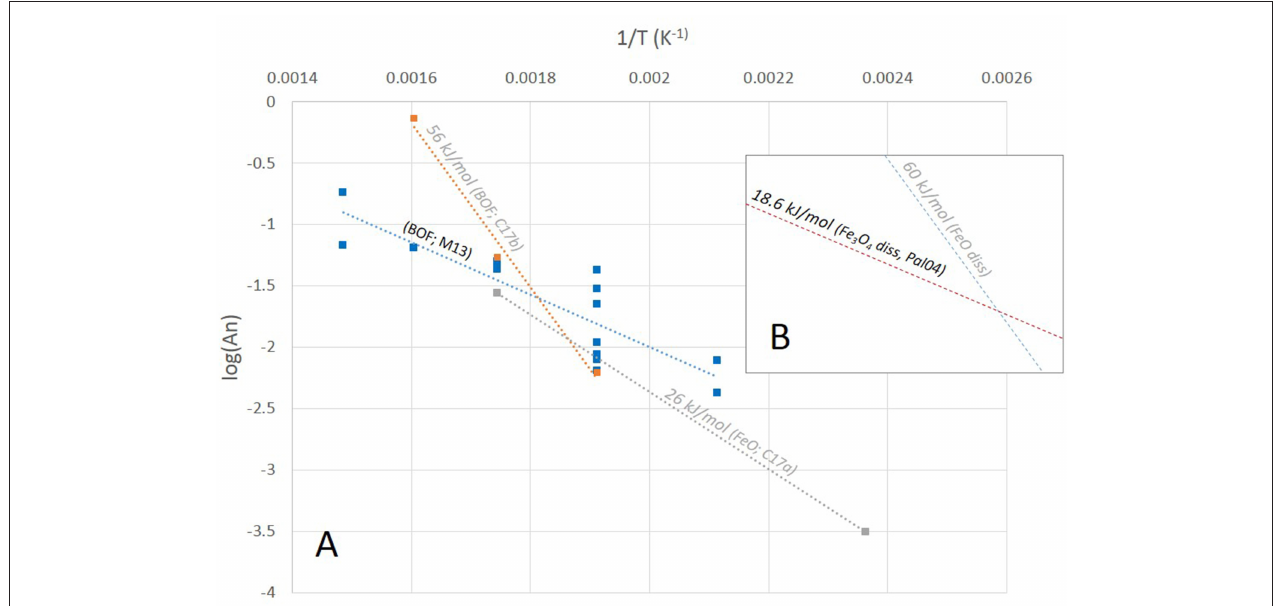
FIGURE 5 | Arrhenius plot of H 2 production reaction from BOF slag and pure FeO. (A) To be plotted, the H 2 production dataset by Malvoisin et al. (2013), or M13 , has been fitted to the An.t 1 / 2 rate-law used by Crouzet et al. (2017a,b), indicated as C 17 a and C 17 b , respectively. Activation energies (Ea) have been retrieved; however, only the M 13 dataset contains sufficient data to retrieve a reliable activation energy with its standard deviation (black font). C17a and C17b datasets is only based on 2 and 3 datapoints, respectively, and the derived Ea is thus only indicative (gray font). (B) For comparison, the dissolution kinetics of magnetite dissolution (and precipitation, Palandri and Kharaka, 2004; Pal04 ) is depicted by an idealized draw line, the slope of which is consistent with the E a tabulated in Pal04 using the scale of (A) plot. The E a of FeO dissolution kinetics of ca. 60 kJ/mol is approximated by combining the room temperature dissolution data at pH < 6, published by Jang and Brantley (2009) and those at 150 ◦ C found in Crouzet et al. (2017a), see text